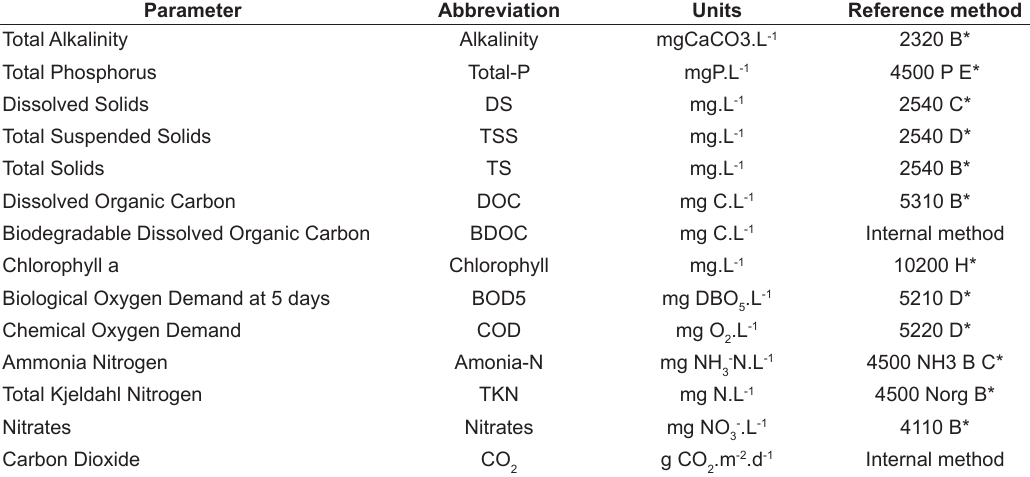
Table 3. Water quality (physicochemical) and Greenhouse gases variables, units and methods of reference measured to the model